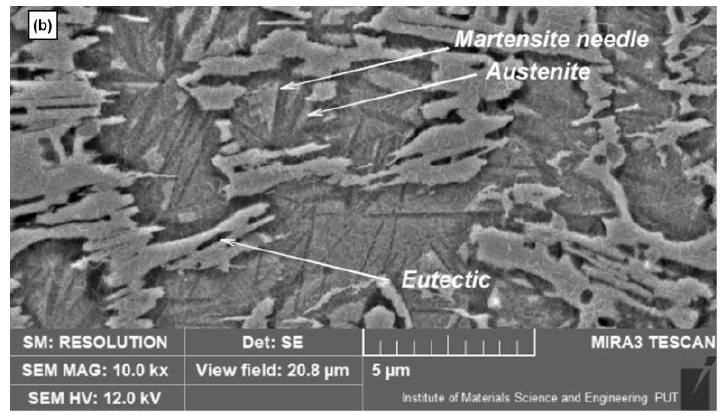
Figure 9. The microstructure of the surface layer after laser implementation of nickel; ( a ) SEM micrographs at 2k × ; ( b ) SEM micrographs 10k × magnification.